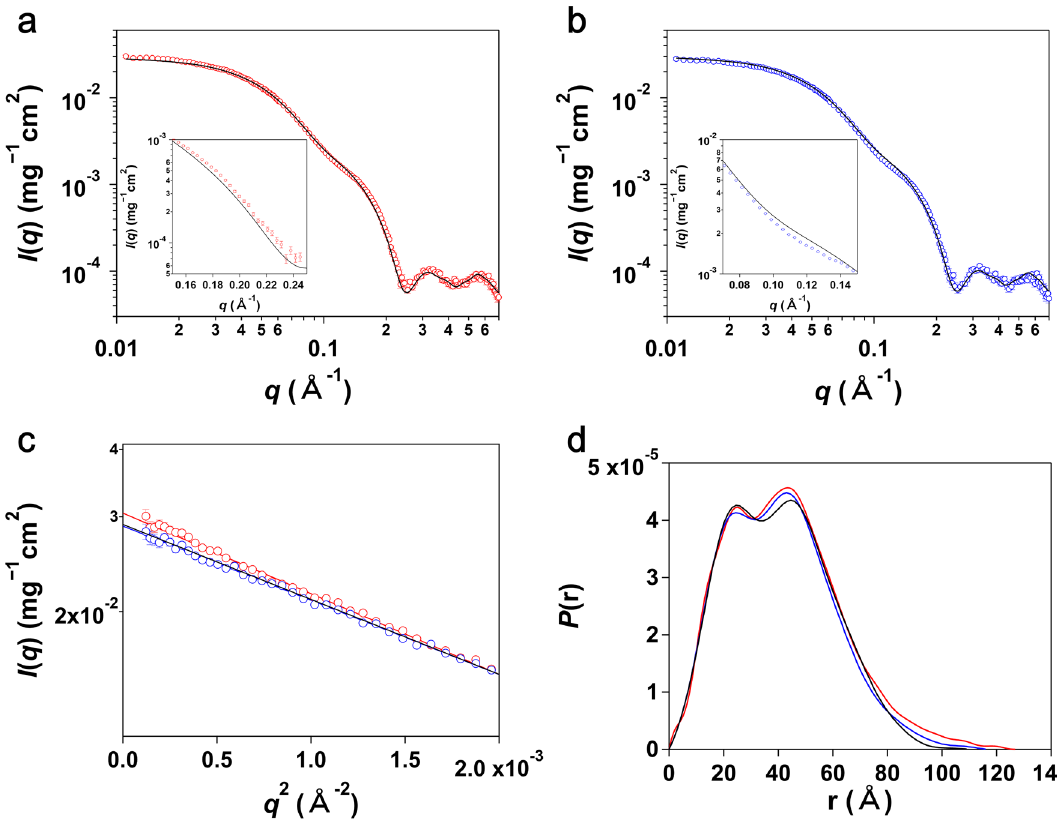
Figure 1. Solution scattering of ER-60. ( a , b ) Small-angle X-ray scattering (SAXS) profiles of oxidized ( a , red circles) and reduced ( b , blue circles) ER-60, respectively. Black lines indicate the profiles calculated from the crystal structure (3F8U). Inset panels are expanded views of them in a q range of 0.17–0.25 Å −1 ( a ) and 0.07–0.15 Å −1 ( b ), respectively. ( c ) Guinier plots of oxidized (red circles) and reduced (blue circles) ER-60. The red and blue straight lines indicate the results of the least square fitting using the Guinier formula: I ( q ) = I (0) exp(− ( R g/3) 2 q 2 ), where R g is the gyration radius and I (0) is the forward scattering intensity. The black line indicates the profiles of the crystal structure (3F8U) in the Guinier plot. ( d ) Pair distance distribution function, P ( r ), of oxidized (red line) and reduced (blue line) ER-60 calculated using GNOM software 36 . The black line indicates the P ( r ) of the crystal structure